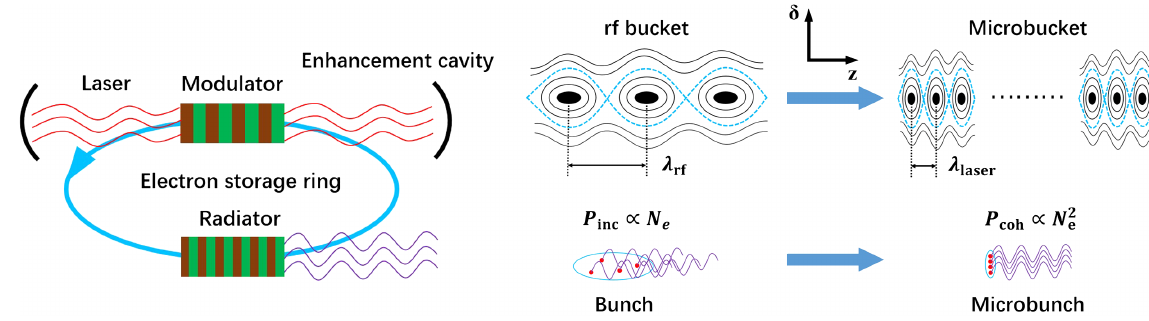
FIG. 1. Schematic layout of SSMB (left) and its operating principle in comparison to a traditional storage ring